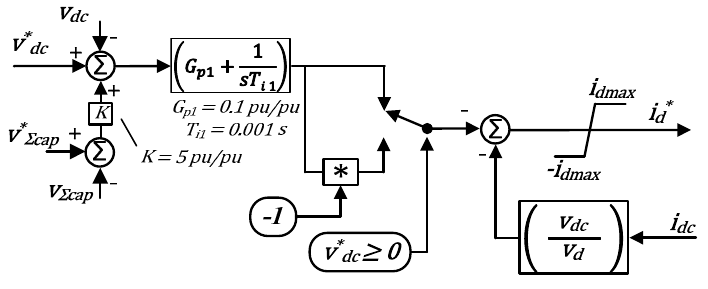
Figure 7. DC Voltage control loop for FBMMC1.